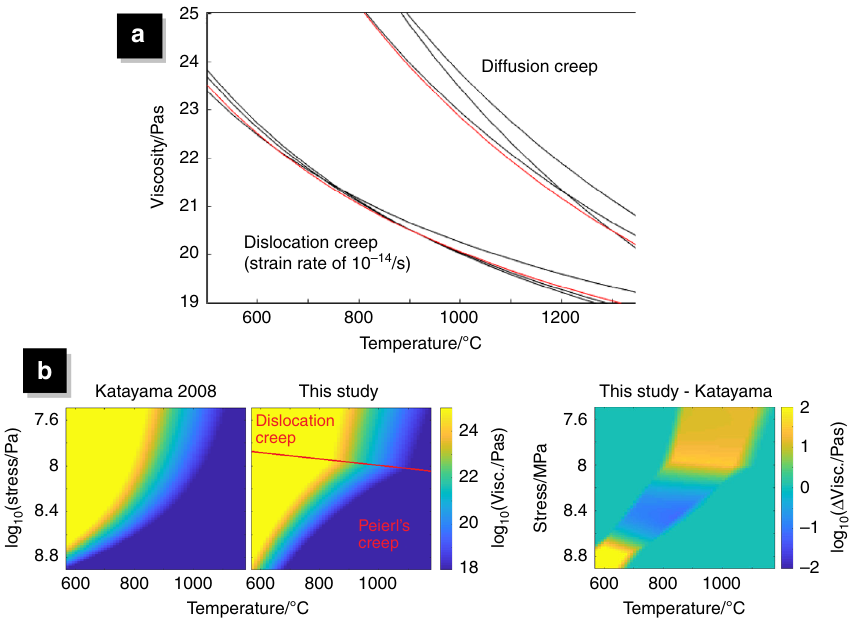
Fig. 6 Illustration of method to choose fl ow law parameters. a The fl ow laws used in this study, for dislocation creep and diffusion creep, are plotted in red. Experimentally determined fl ow laws for hydrated peridotite, commonly used for mantle material in geodynamic numerical models, are plotted in black for reference. The studies that determined these diffusion creep fl ow laws are (listed from strongest to weakest at 1000°C): Hirth and Kohlstedt 43 , Jaoul et al. 44 , and Houlier et al. 45 . Similarly, the studies for these dislocation creep fl ow laws: Kirby and Kronenberg 46 and Hirth and Kohlstedt 43 Karato and Wu 47 . b We use an approximate Arrhenius formulation of the exponential fl ow law for Peierl ’ s creep of hydrated peridotite, determined by Katayama and Karato 36 (as our modelling technique does not allow for exponential fl ow laws). We used a parameter grid search to minimise the total mis fi t between our fl ow law and the fl ow law of Katayama and Karato 36 in temperature-stress space (using our yield stress, or 8 × 10 8 Pa, as the maximum stress). These panels show the viscosity as given by Katayama and Karato 36 ; the viscosity used in our study; and the minimised mis fi